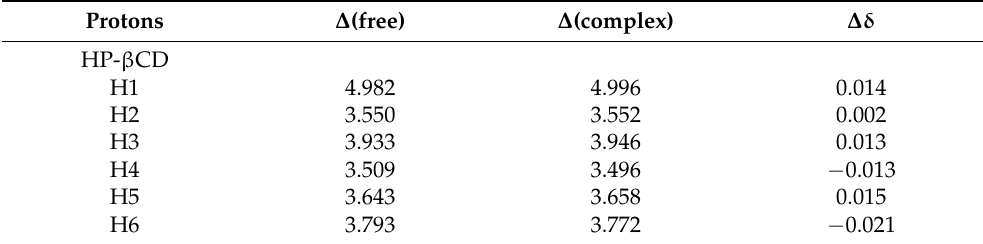
Table 2. Changes in chemical shift ( ∆ δ , ppm) of HP- β CD in free and complexed